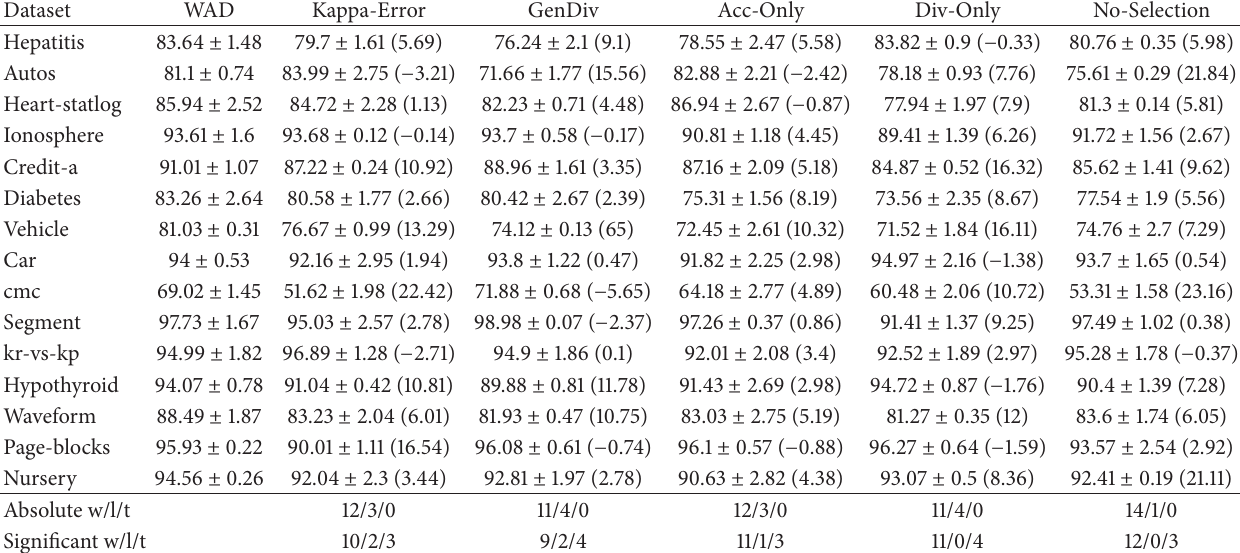
Table 6: The classification correct rate (%) of subensembles selected by candidate measures and forward hill-climbing search algorithm using a pairwise t -test at a 95% significance